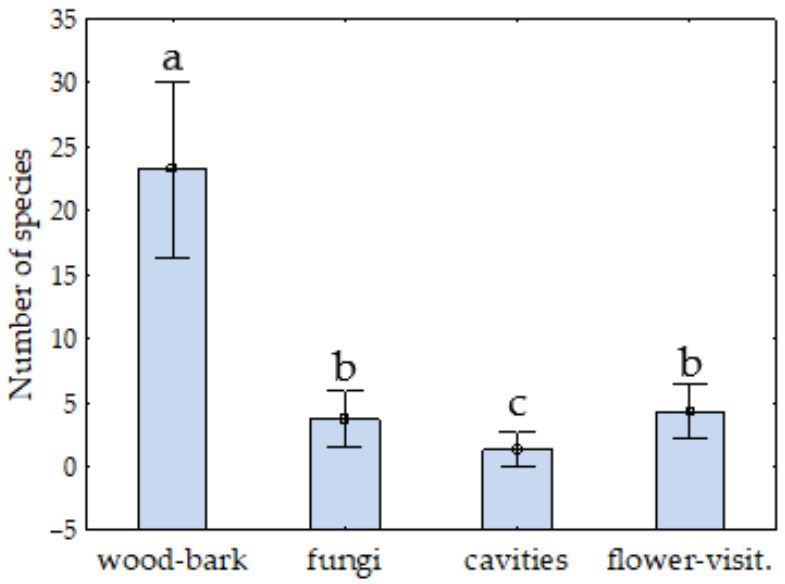
Figure 10. Distribution of species according to groups: wood-bark specialists; fungi specialists; cavity specialists; adult flower visitors. Error bars are standard deviation and solid point is mean (mean ± SD). Letters above error bars indicate differences by Dunnett post-hoc test (MS = 14.679, df = 136.00).